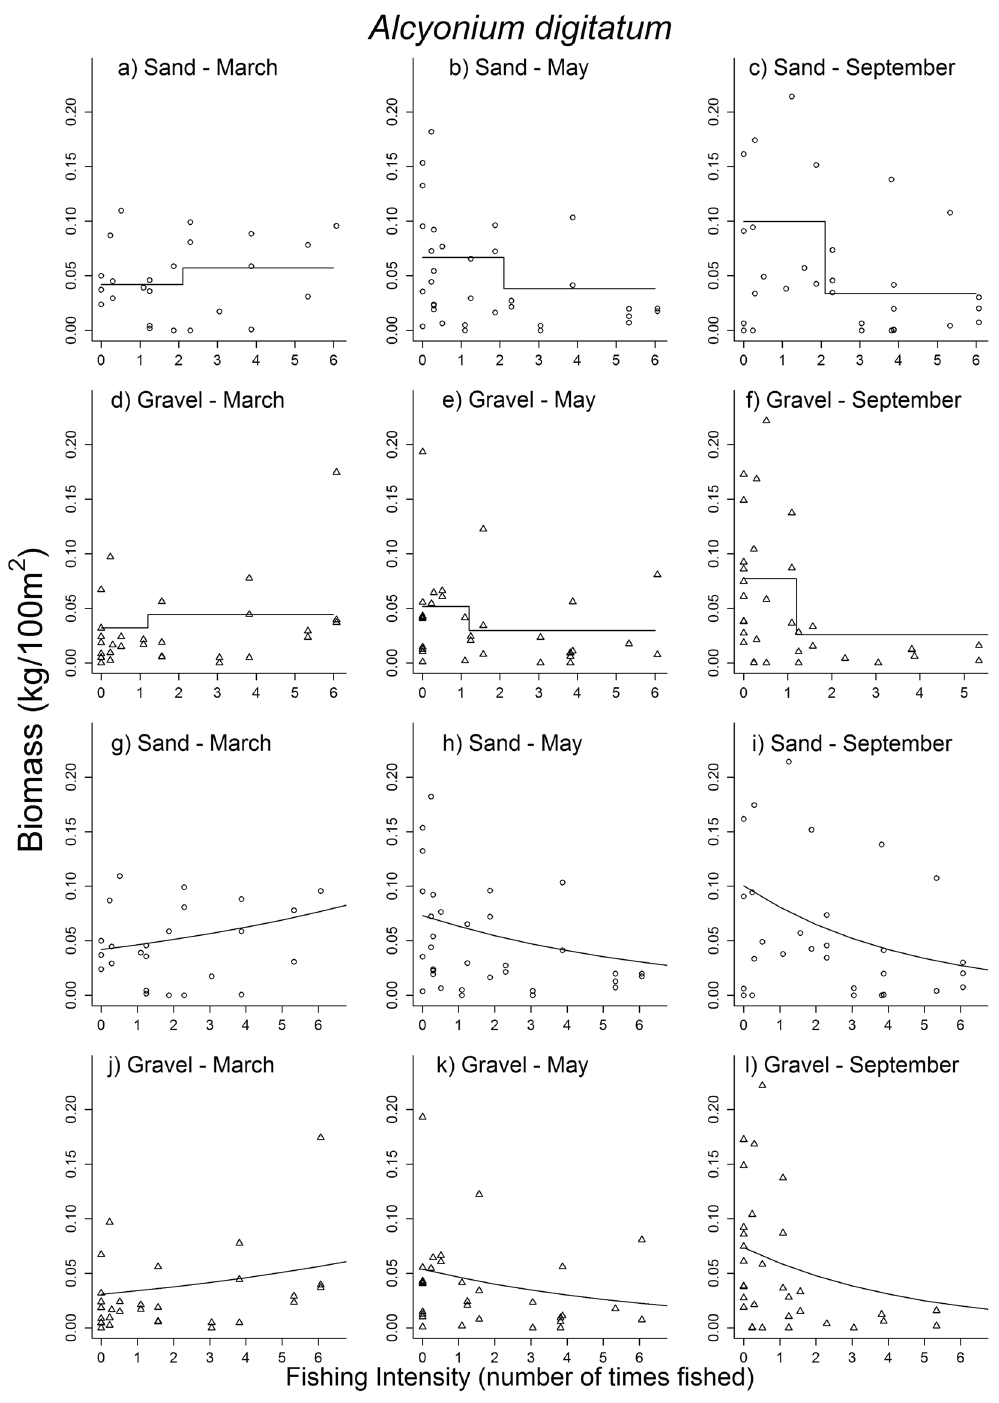
Figure 4. Effect of scallop dredging on the biomass of dead men’s fingers ( Alcyonium digitatum ). Left to right: March (prior to fishing), May (after fishing) and September (four months after fishing). Each symbol is a sample, distinguishing sand and gravel types. Observed values are fitted with GLMMs outputs from the threshold analysis ( a–f ) (best model with AIC = 952.37) and with fishing as a continuous variable ( g–l ) (AIC =